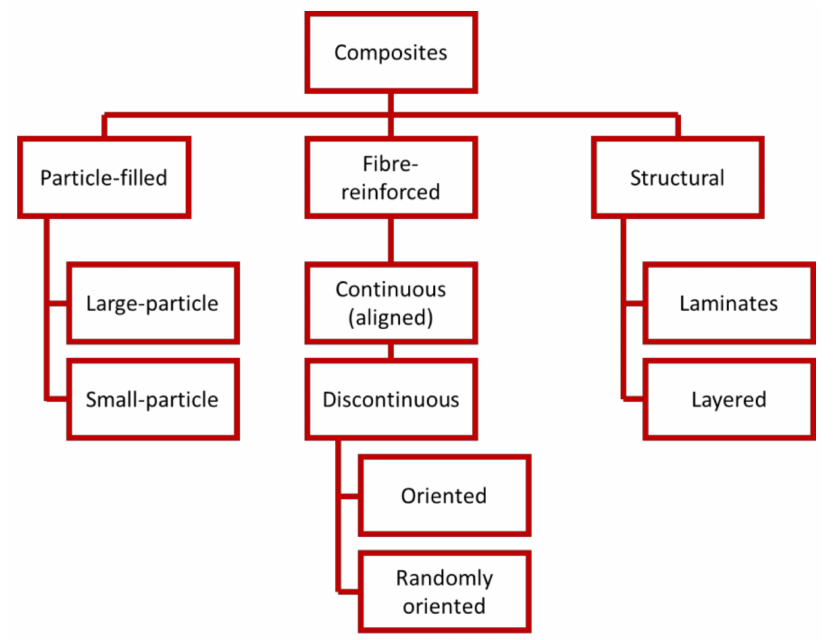
Figure 1. Types of reinforcements in composites. Redrawn with permission from Saba and Jawaid